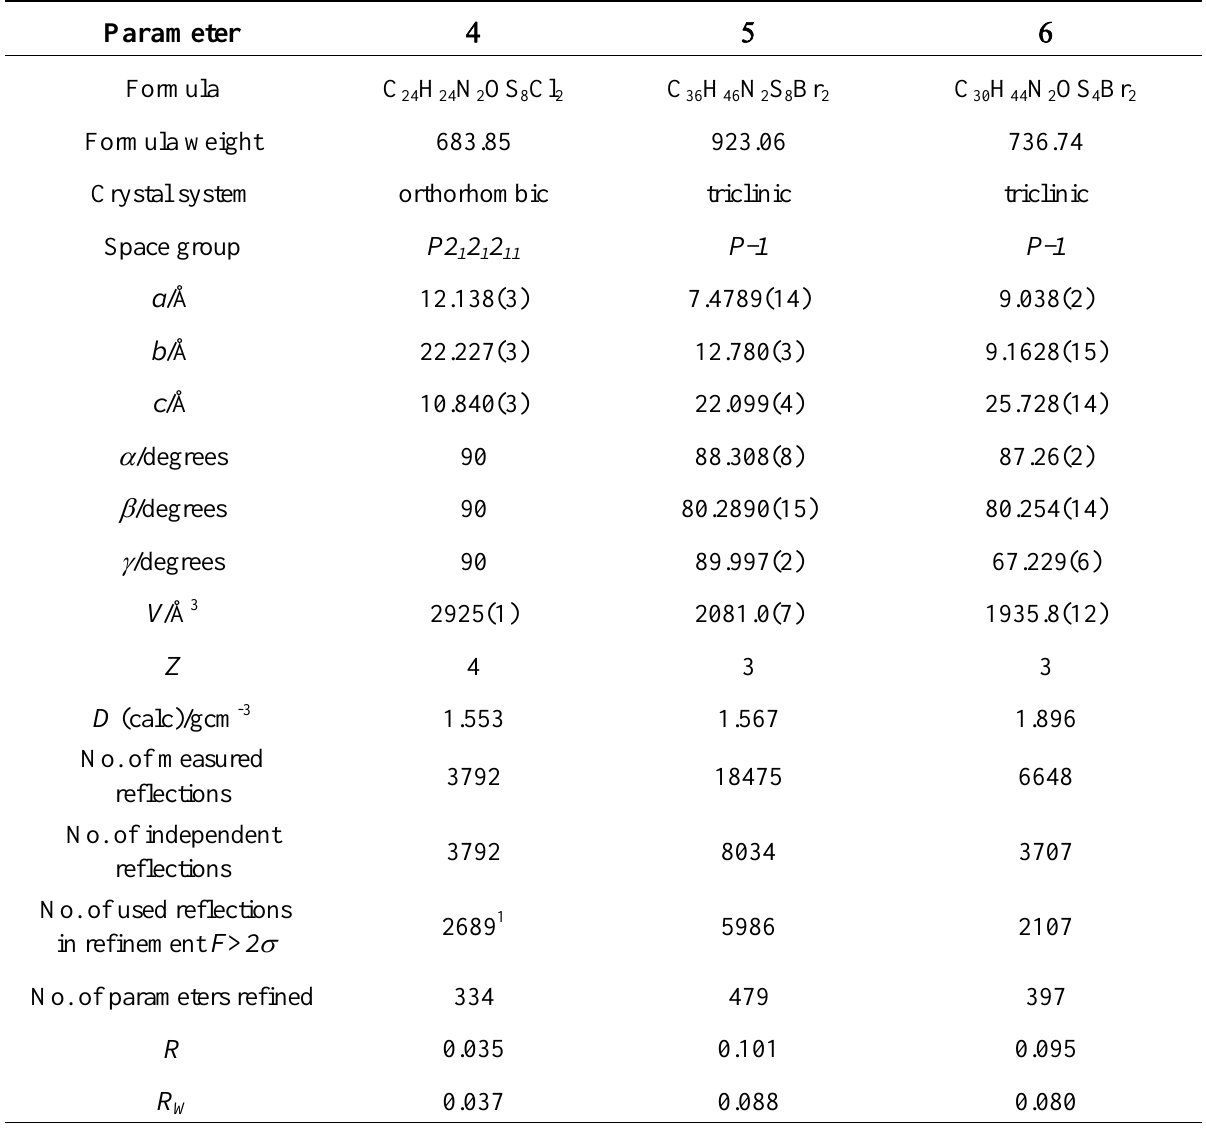
Table 1. Summary of crystal data for 4 , 5 and 6